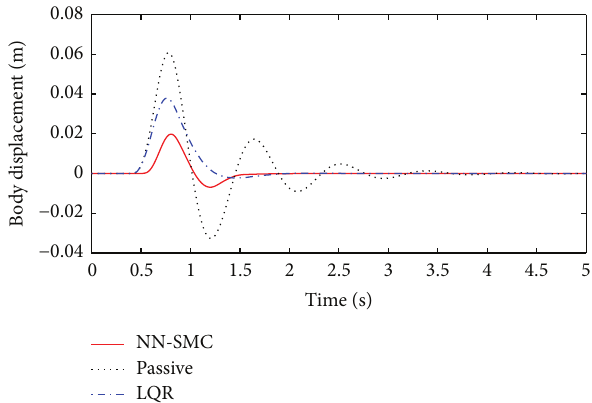
Figure 9: Body displacement (Case 2).